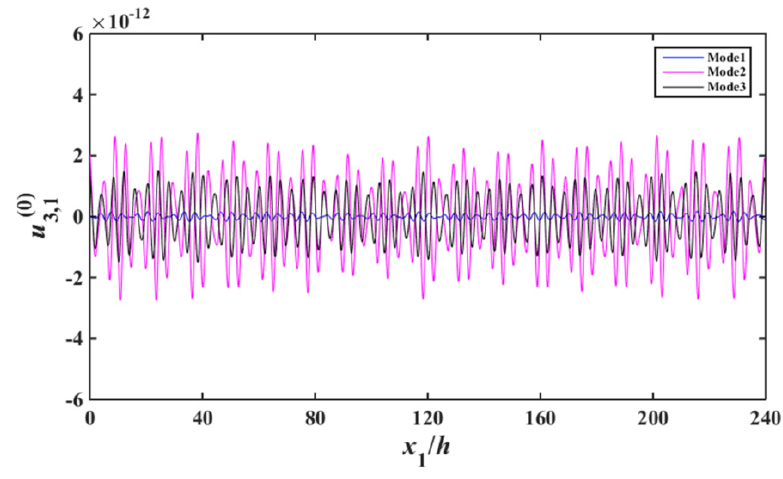
( 0 ) ( ) 0 u ). Figure 7. Face-shear strain distribution near resonance ( u 3,1 3,1